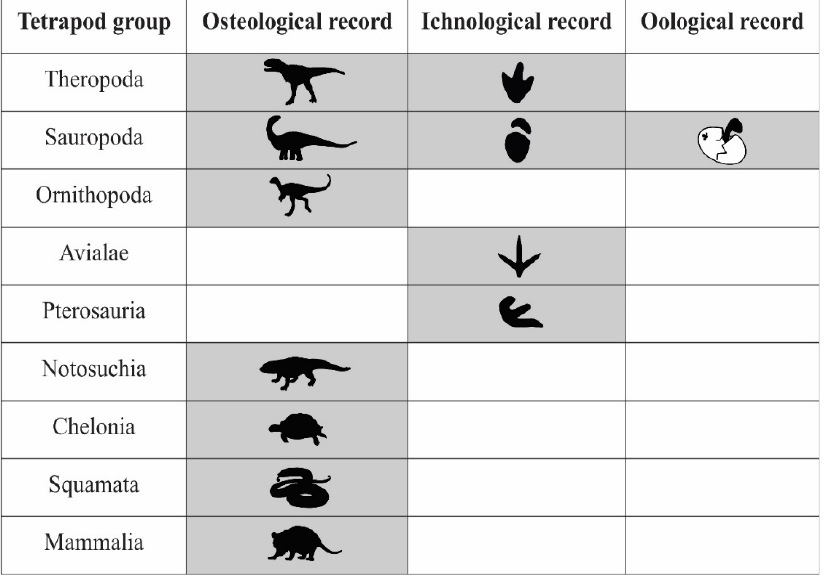
Figure 5. Tetrapod osteological fossil and ichnofossil record of the Anacleto Formation. References: Dark grey with drawings, presence of the remains; white without drawings, absence of the remains. The figure is based on the works cited in the text.